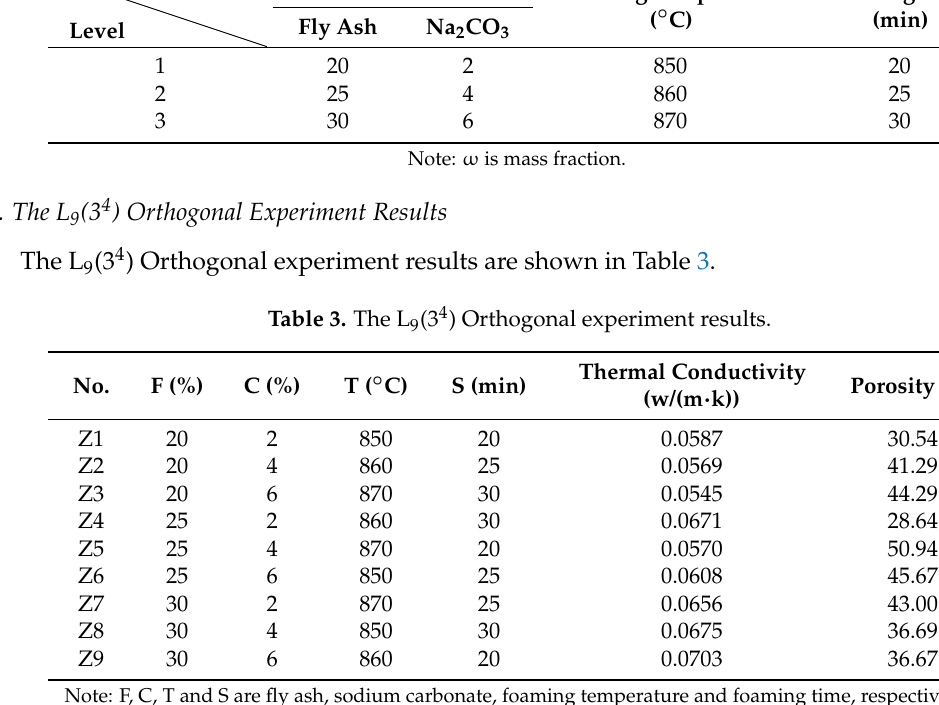
Table 2. The L 9 (3 4 ) Orthogonal test factors and levels.